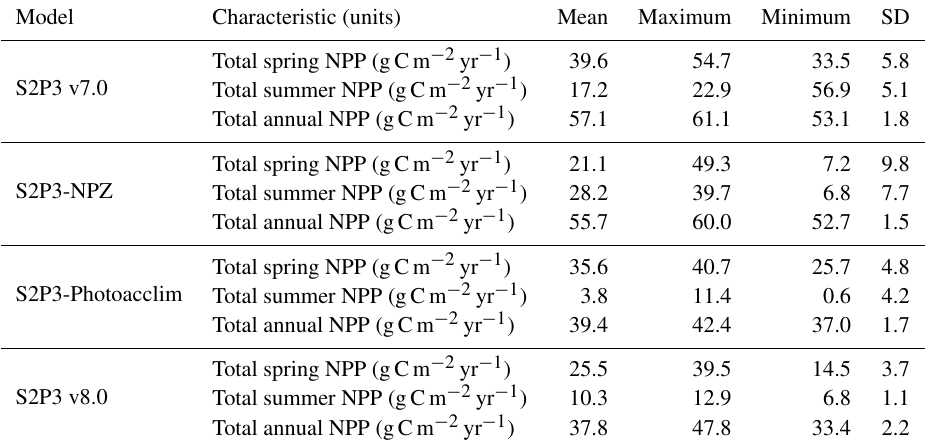
Table 3. Comparison between the S2P3 v7.0, S2P3-NPZ, S2P3-Photoacclim, and S2P3 v8.0 models calibrated for the CCS location, in terms of the total spring NPP, total summer NPP, and total annual NPP calculated from 1965 to 2015, including the mean, maximum, minimum, and SD